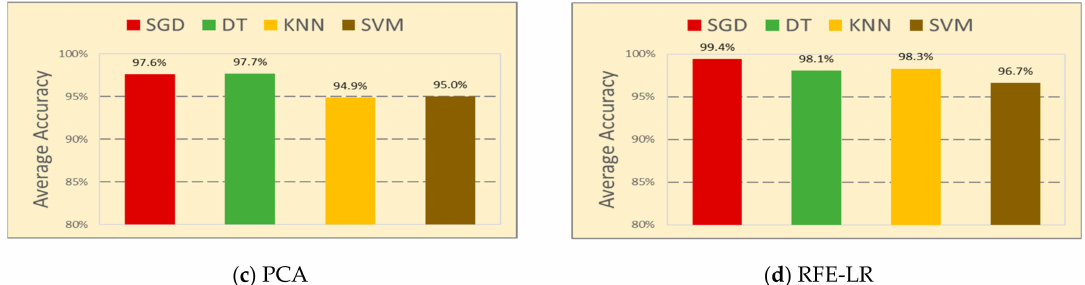
Figure 9. The average accuracy of human detection in di ff erence